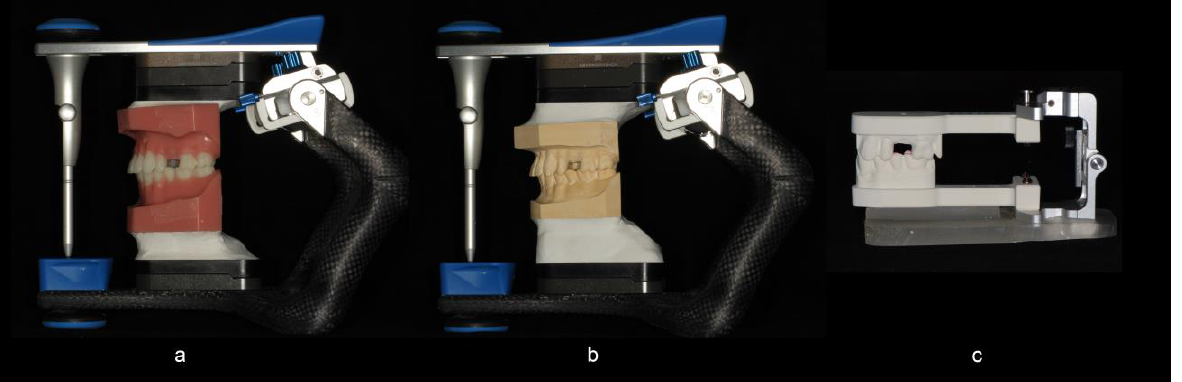
Figure 1. ( a ) The master model and ( b ) conventional stone casts were mounted on a semi-adjustable articulator. ( c ) The milled quadrant models were mounted on a prefabricated articulator (Itero Cadent Articulator) from the milling center based on the data obtained from the buccal scanning procedure.